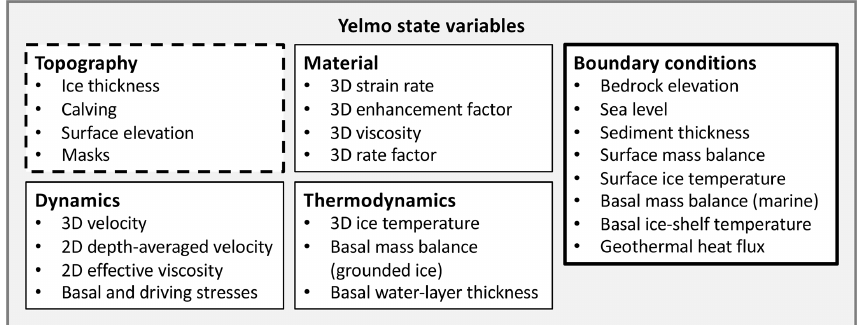
Figure 1. Overview of the Yelmo model structure highlighting state variables in the four components: topography, dynamics, material and thermodynamics, as well as the boundary conditions required to run the model. The thick black border for boundary variables indicates that these fields are never modified internally by Yelmo, while the components with a thin black border or dashed line are allowed to be modified depending on the context. When, for example, the topography is updated (dashed line), no other components are allowed to be modified (solid